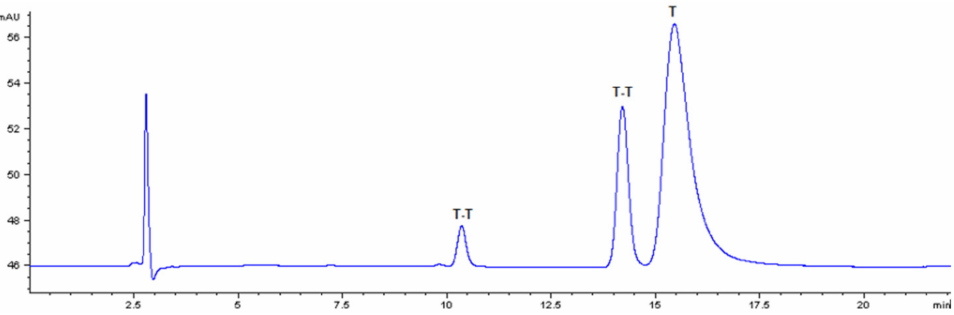
Figure 8. Elution profile of a thymine (T) solution at 80 µ M photoirradiated at 254 nm for 10 min. Detection wavelength 220 nm. T-T: thymine